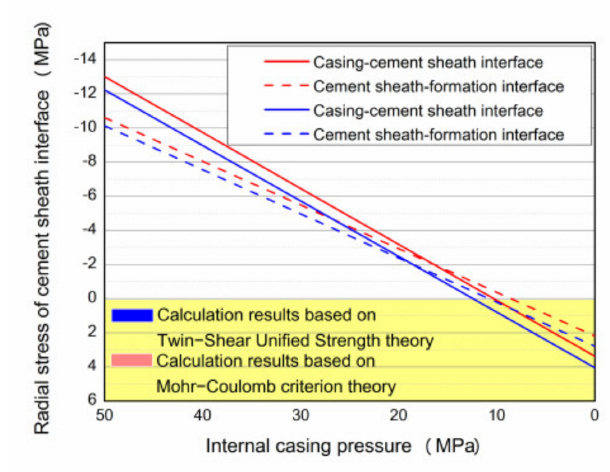
Figure 6. Interface stress change in the cement sheath during unloading.